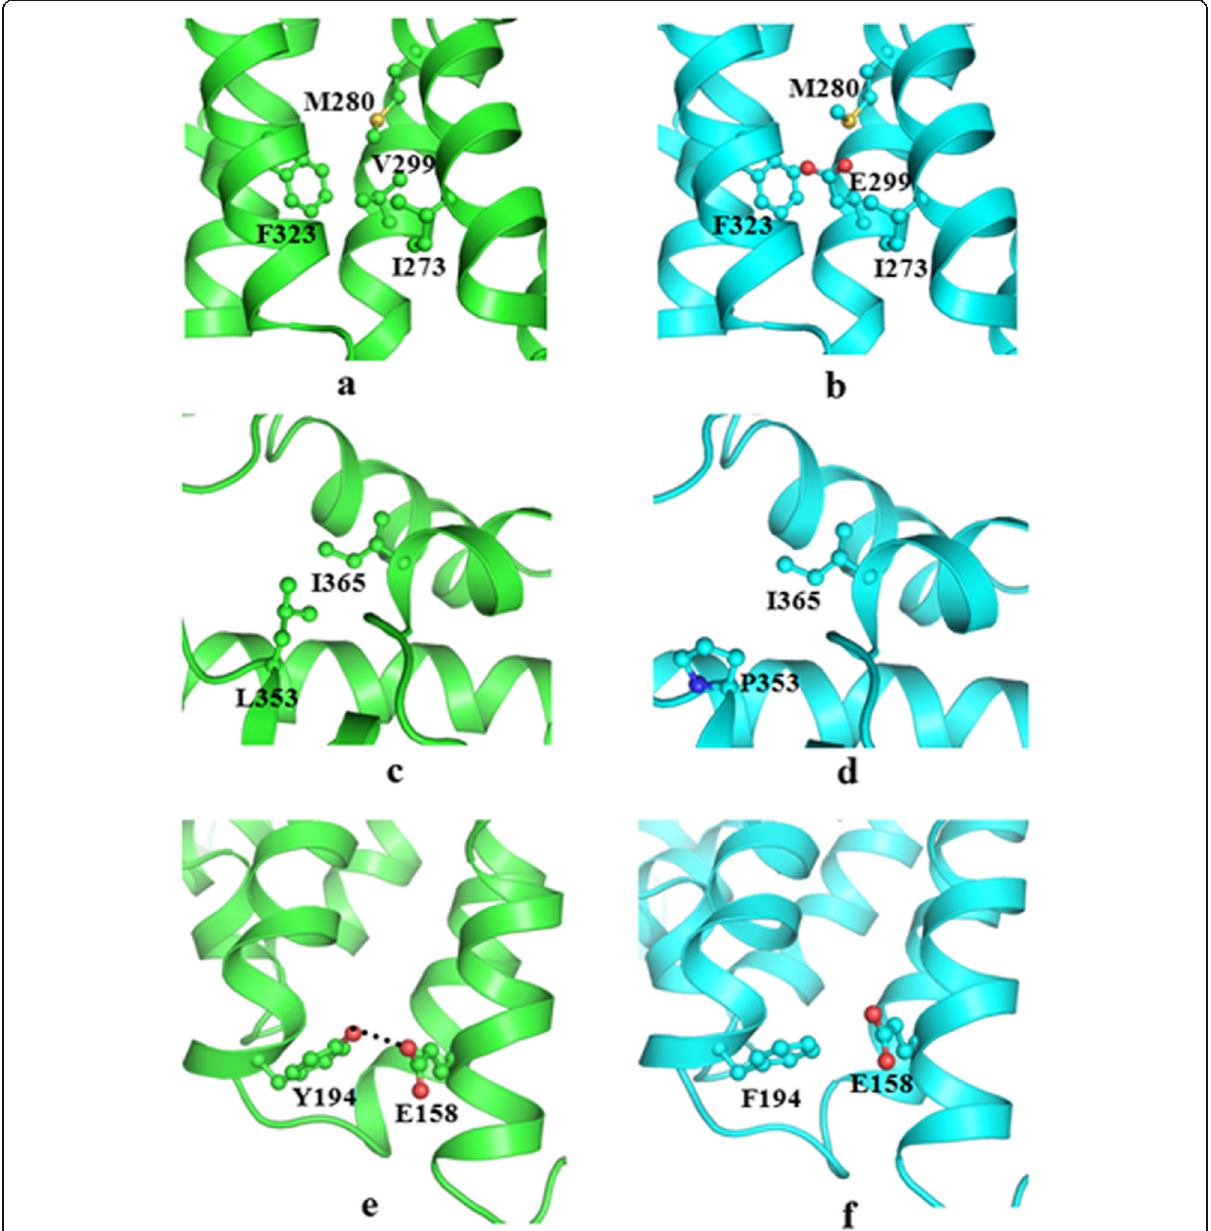
Fig. 3 Cartoon representation of TSC1 interacting domain of wild type TSC2 (cartoon, green) in ( a , c & e ) and mutants (cartoon, cyan) in ( b ) Val299Glu, ( d ) Leu353Pro and ( f ) Tyr194Phe. Important residues have been represented in ball and stick and hydrogen a bonded interaction is shown as black dotted